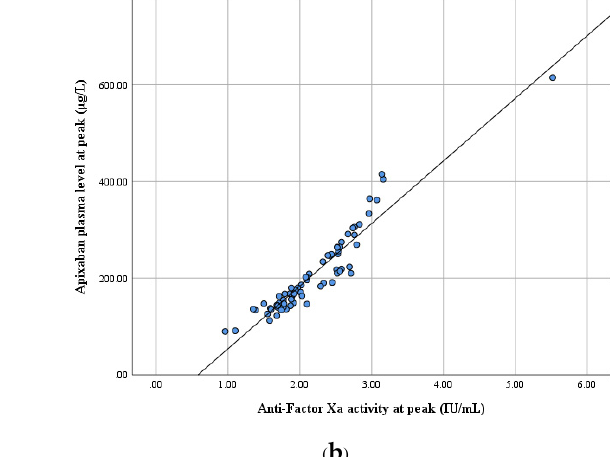
Figure 1. Scatterplot between the apixaban plasma level and anti-FXa activity. ( a ) At the trough and ( b ) at the peak.